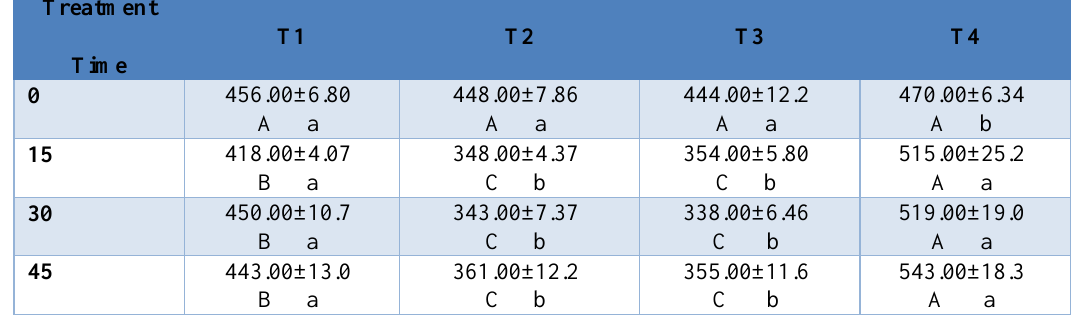
Table ,4: Effects of Salvia Officinal's(SO) and Salvia officinal's Silver Nanoparticles (SOSNP) on Malonydialdehyde (MDA) concentration (μmol/L) in normal and methotrexate (MTX) treated rats